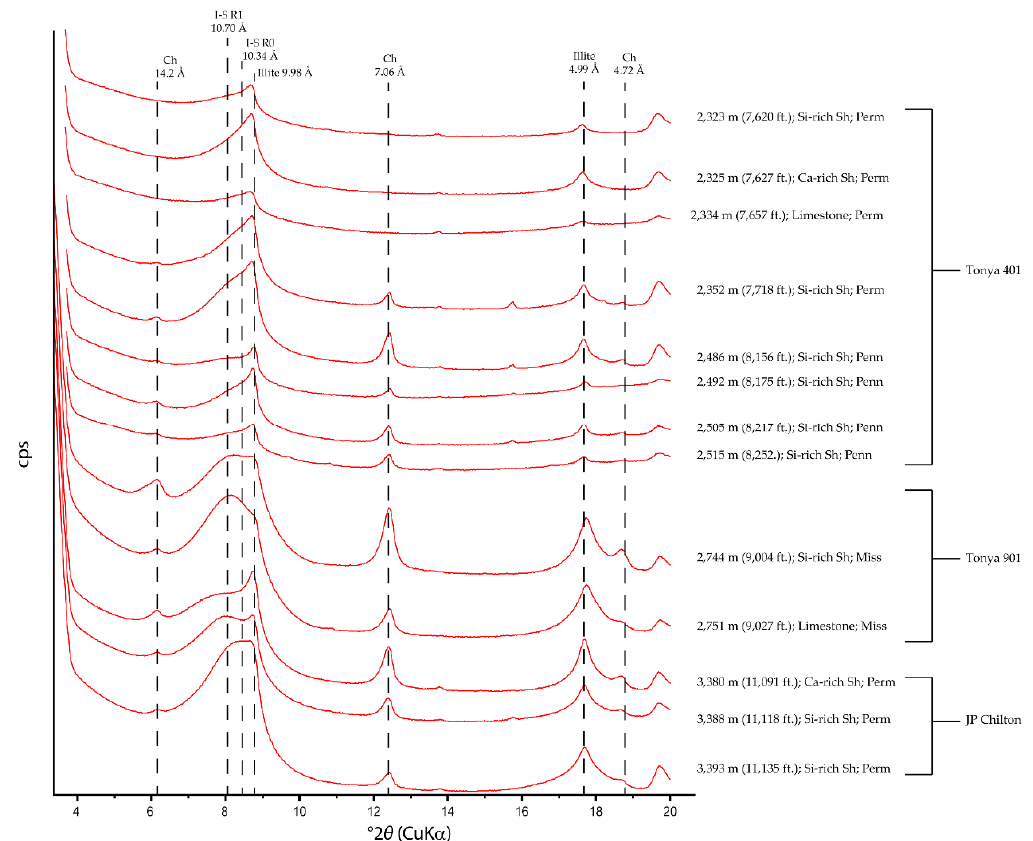
Figure 7. Deconvolution of XRD patterns of clay fraction for four representative samples. ( A -T401-7673, B - T401-8197, C -T401-8252, and D -JP Chilton-11118). The experimental XRD pattern is blue with the modeled fit being orange, with phases of illite (grey), chlorite (green), R0 I-S (yellow), R1 I-S (pink), R3 I-S (red), and R0 I-SS (dark blue).